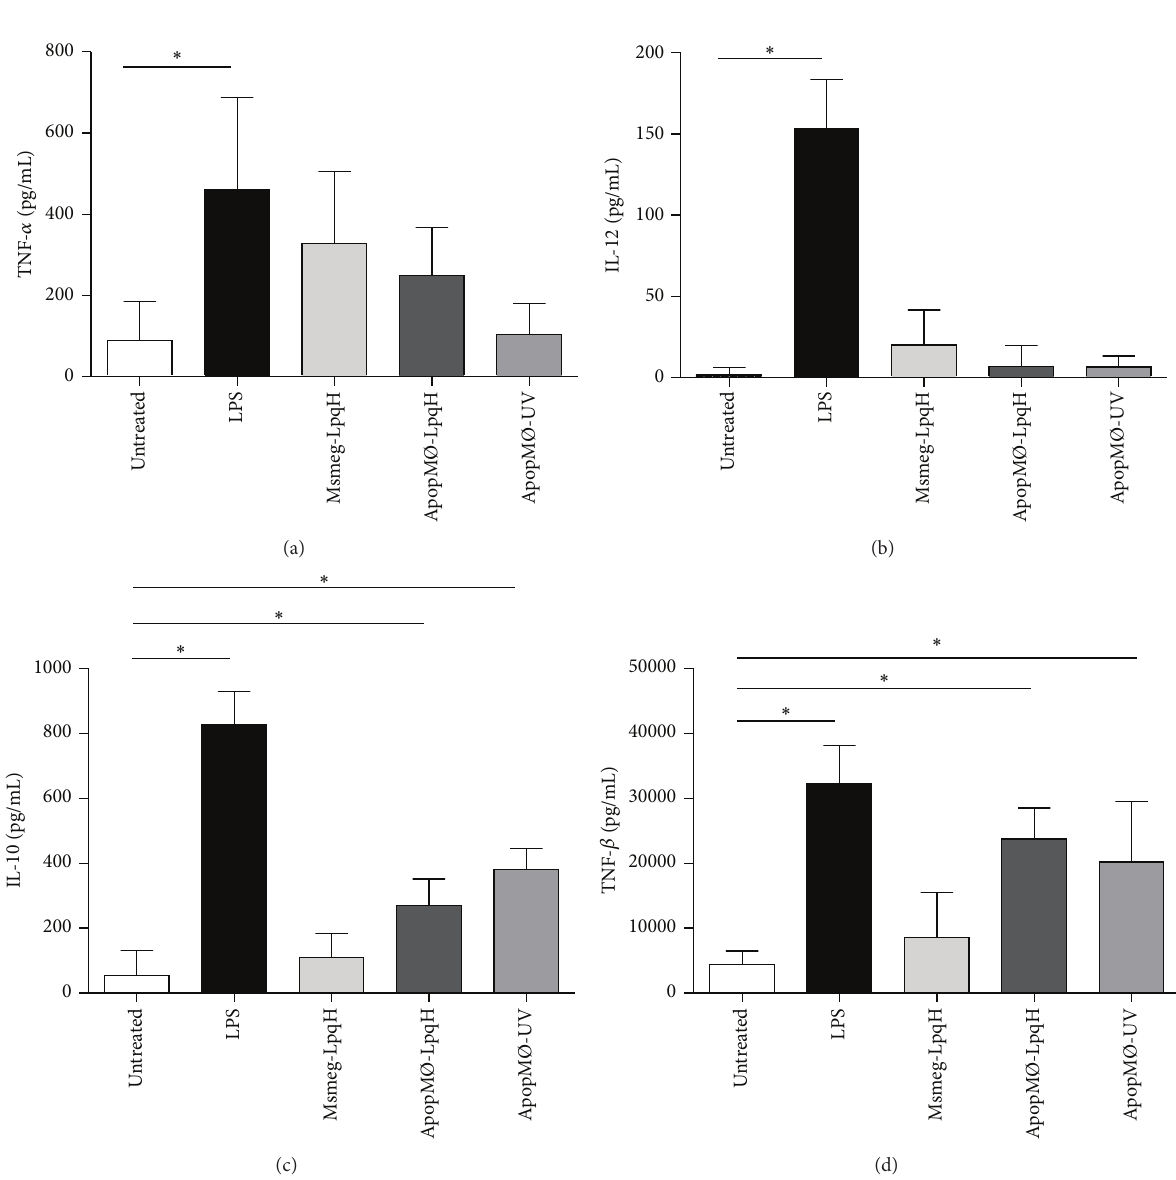
GTPase is involved in this process [47]. Using